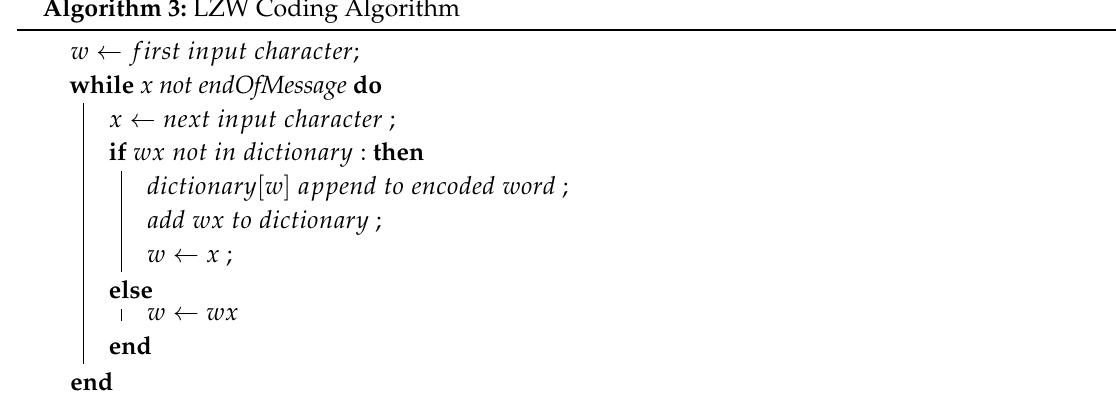
Algorithm 3: LZW Coding